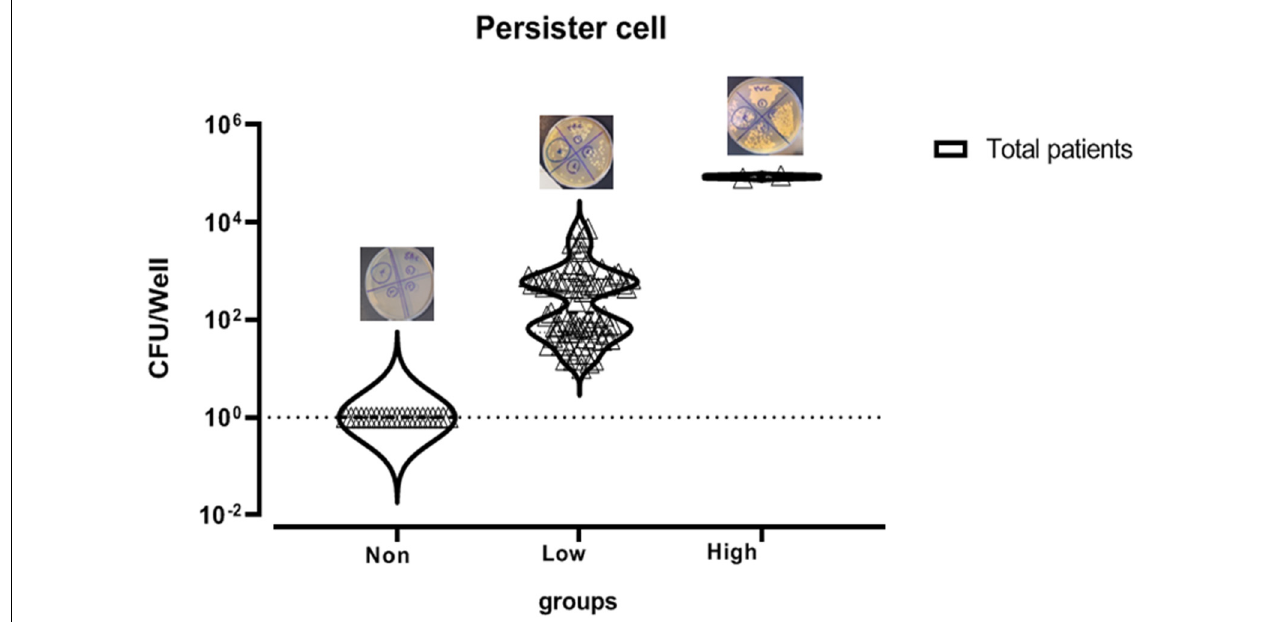
FIGURE 2 | Mean survival rate or persister cell of Candida albicans isolates based on logarithmic data. TABLE 4 | Information from two patients with high persister cells isolated from Candida albicans . Age Candida-load Viral-load CD4-count Type of cancer